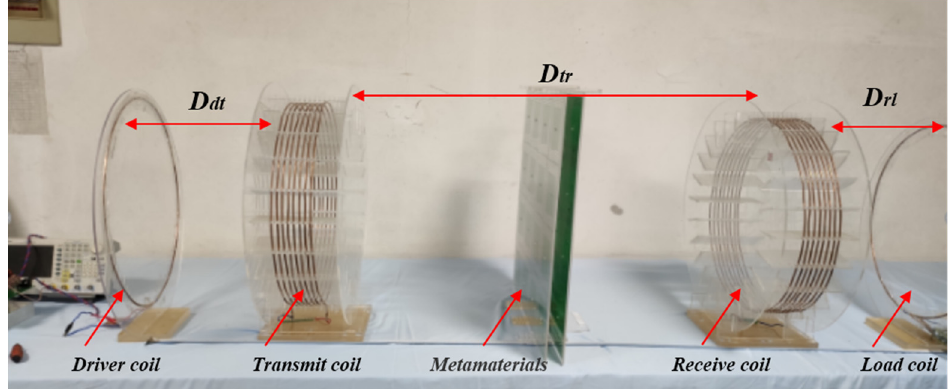
Figure 7. Physical picture of the experimental apparatus.